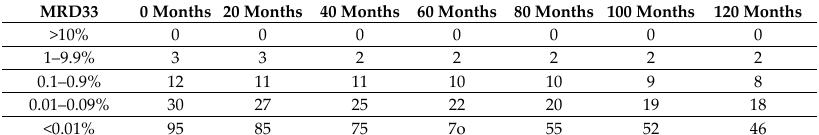
Number of patients at risk.